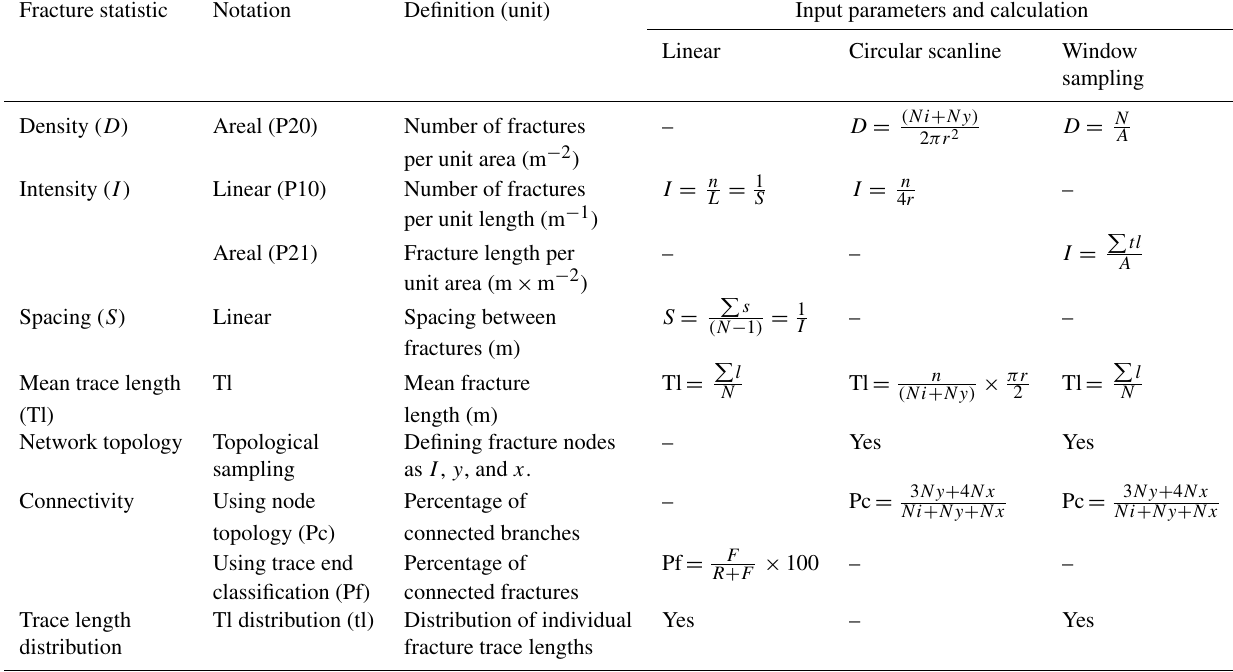
Table 1. Summary and definition of fracture statistics that can be derived from methods used in this work. Table adapted from Zeeb et al. (2013). Ni : number of i nodes, Ny : number of y nodes, Nx : number of x nodes, r : radius of circular scanline, N : number of fractures, A : area, n : number of fracture intersections with the scanline (either linear or circular), L : length of scanline, s : spacing between adjacent fracture traces on the scanline, tl: individual fracture trace length, F : fracture abuts against another fracture, R : fracture terminates into rock (some authors also distinguish strata-bound fracture terminations). “Yes” for trace length distribution and network topology indicates that the method can be used to carry out the